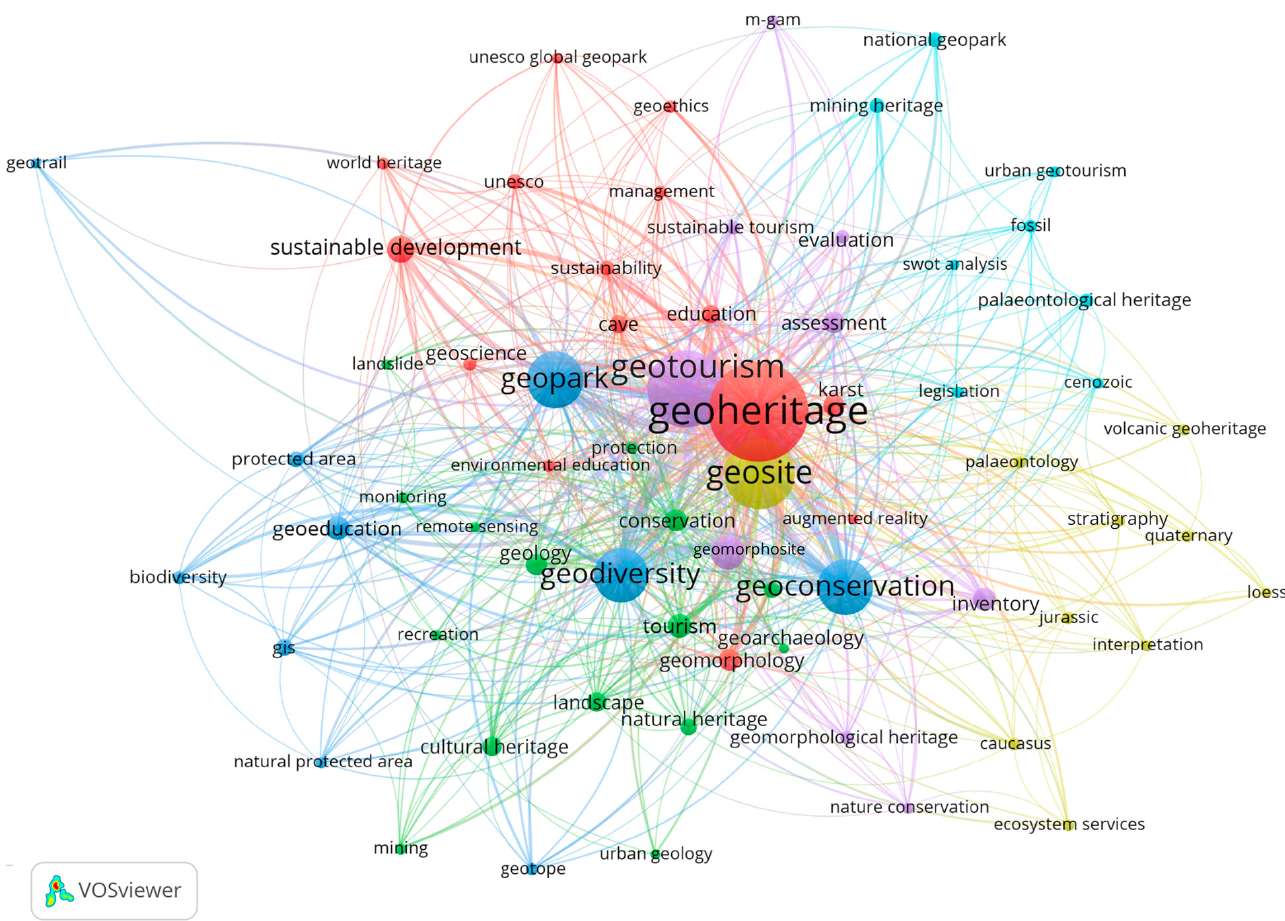
Figure 6. Map of co-occurrence of author keywords, with six clusters, 67 nodes, and 620 links. Cluster 3 (purple colour), “ Geotourism ”, consists of nine nodes with 758